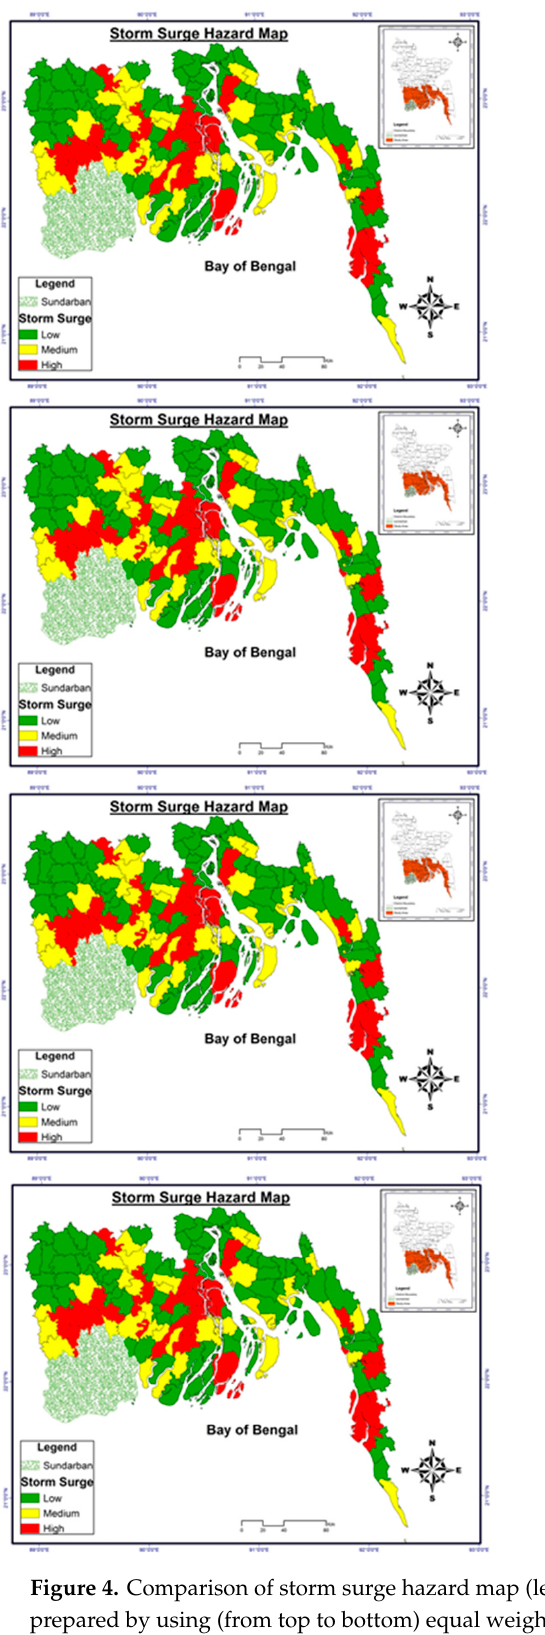
(right) prepared by using MSF.